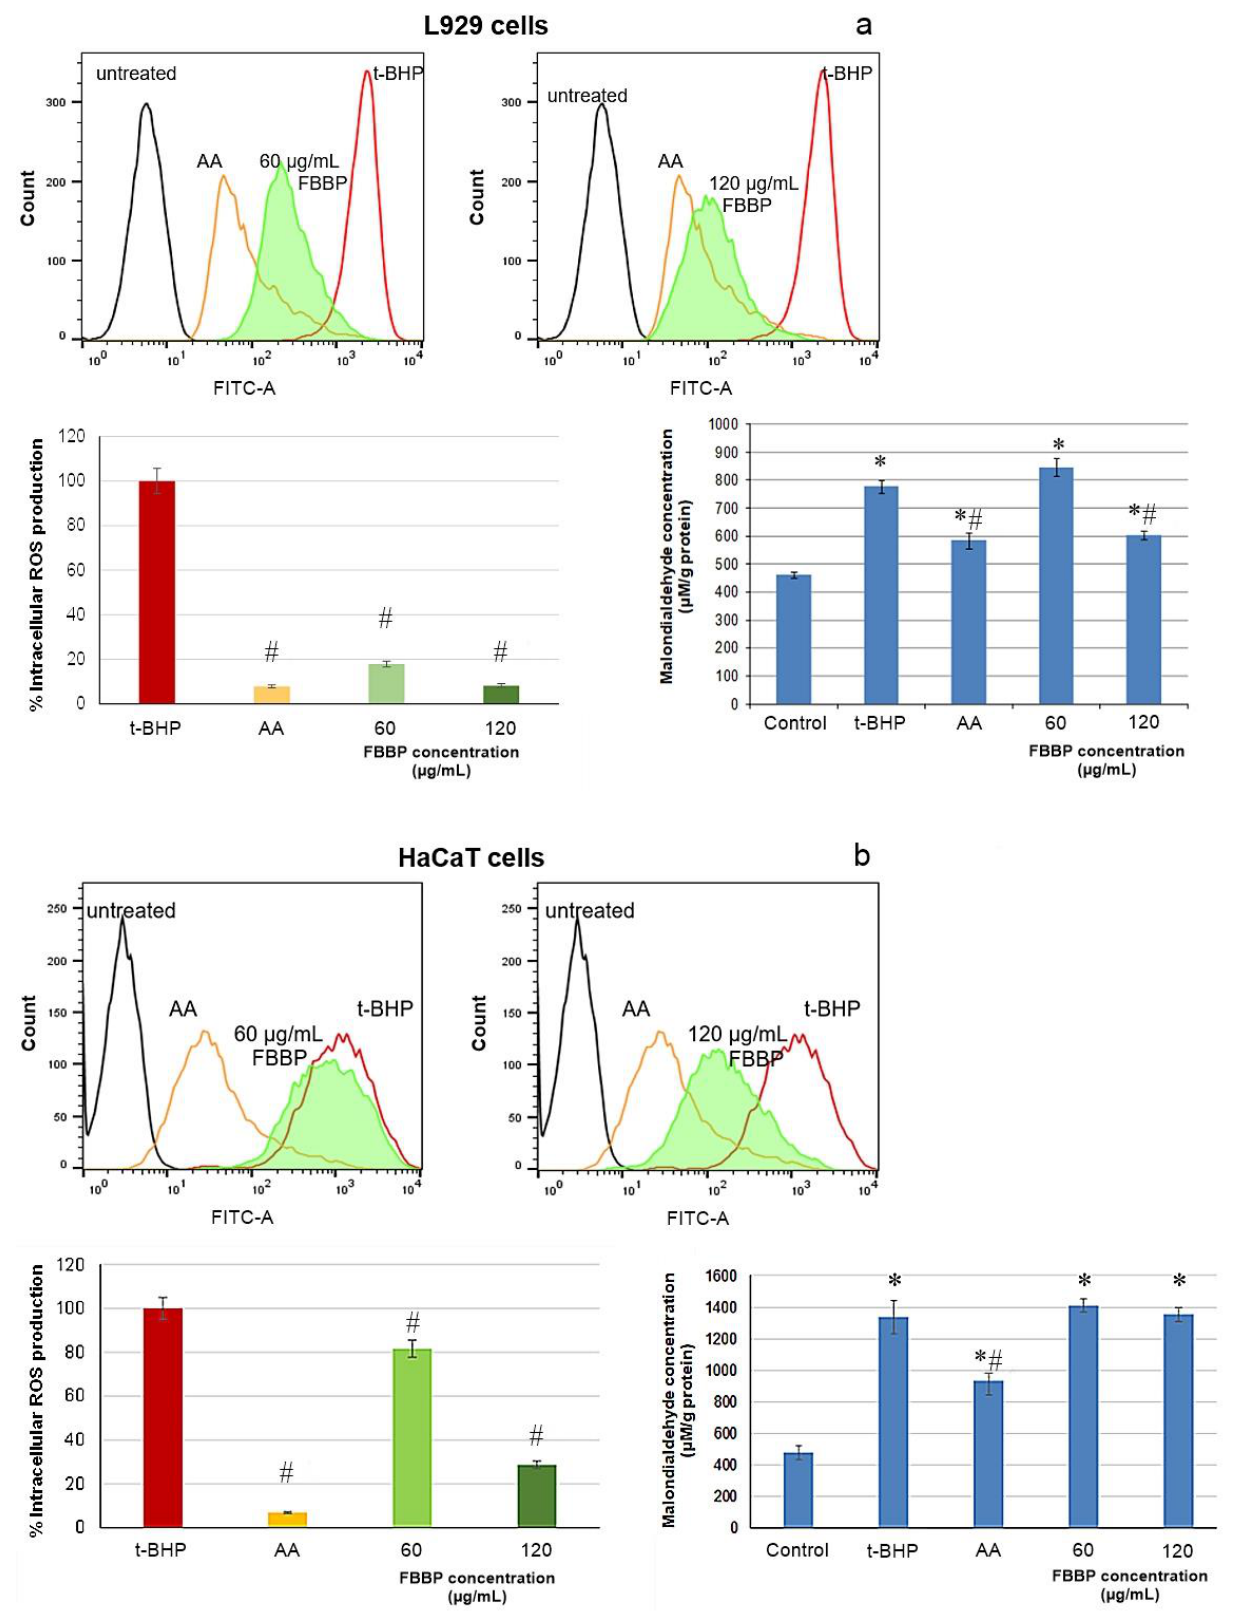
Figure 5. Level of intracellular ROS and MDA production in tert-butyl hydroperoxide (t-BHP) oxidative stress model of L929 ( a ) and HaCaT ( b ) cells treated with different concentrations of FBBP and AA, determined by flow cytometry and TBARS assay, respectively. * p < 0.05, compared to untreated control; # p < 0.05, compared to t-BHP-stressed control.